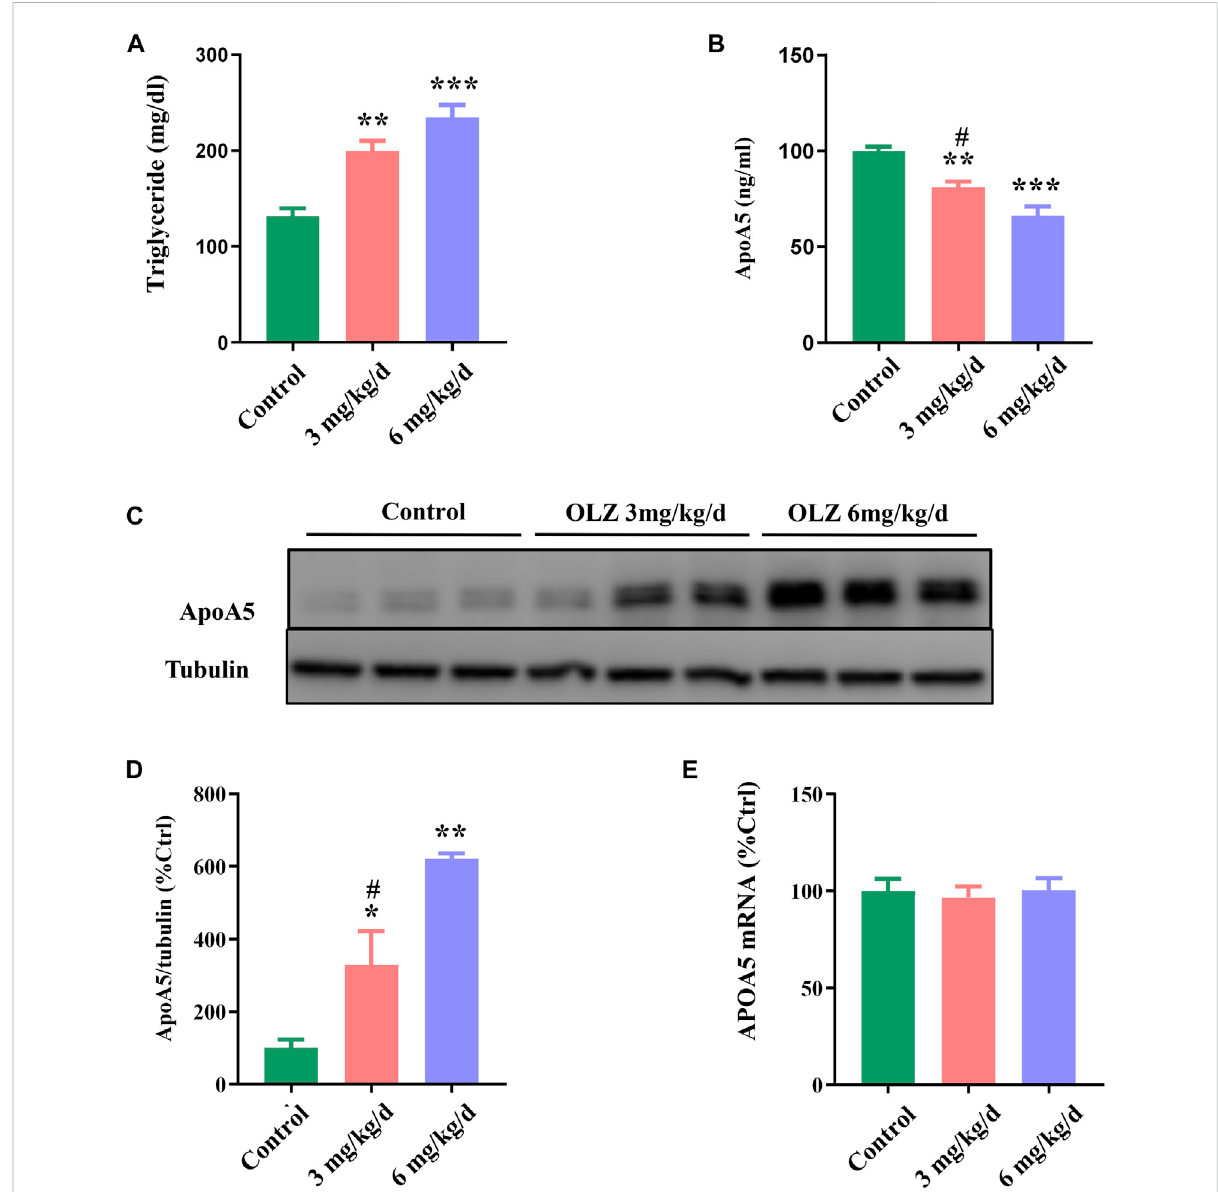
FIGURE 2 The effects of olanzapine (OLZ) on plasma triglyceride and apoA5 levels in mice. (A) Plasma triglycerides and (B) apoA5 levels in olanzapine- treated mice. Hepatic apoA5 protein (C,D) and ApoA5 mRNA levels (E) in olanzapine-treated mice. Data represent the mean ± SEM. * p < 0.05